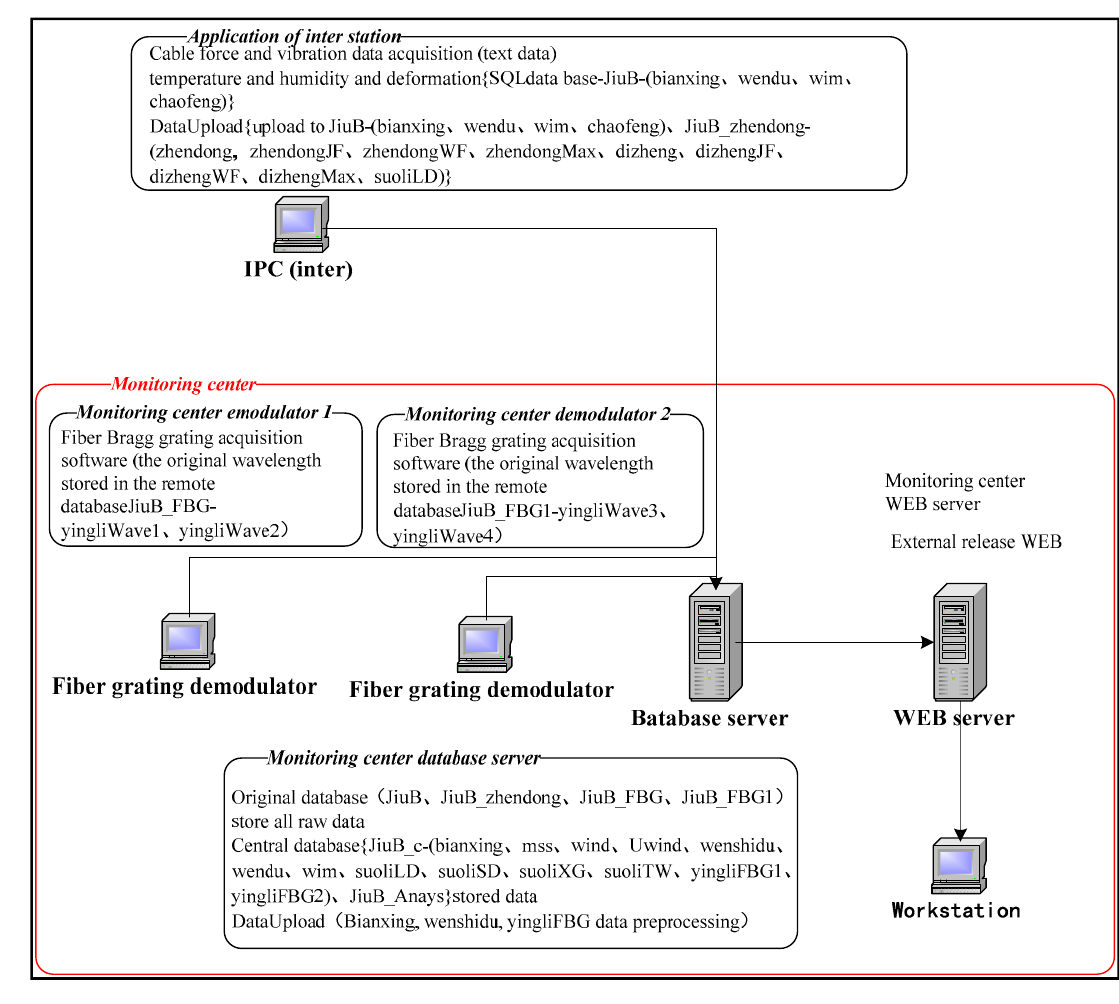
Figure 8. Diagram of equipment function in monitoring center.